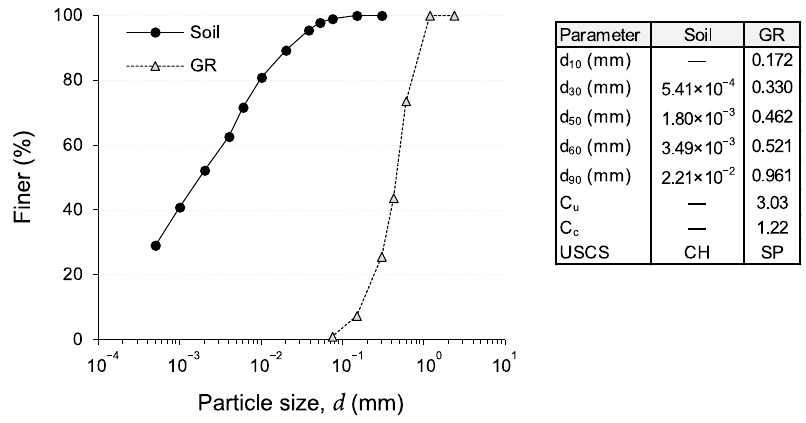
Figure 1. Particle-size distribution (PSD) curves for the test materials.